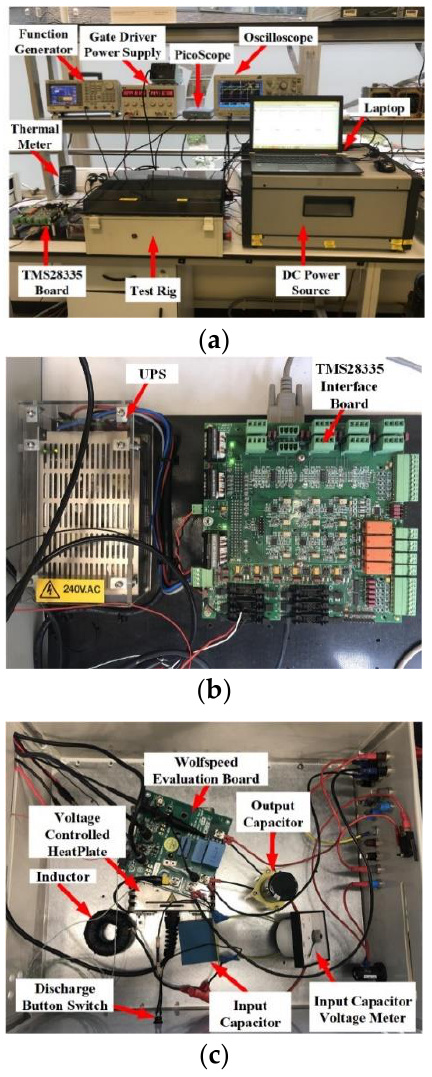
Figure 11. Boost converter test setup: ( a ) overall test bench; ( b ) TMS28335 PWM generating board; ( c ) test rig inside view. ( c ) test rig inside